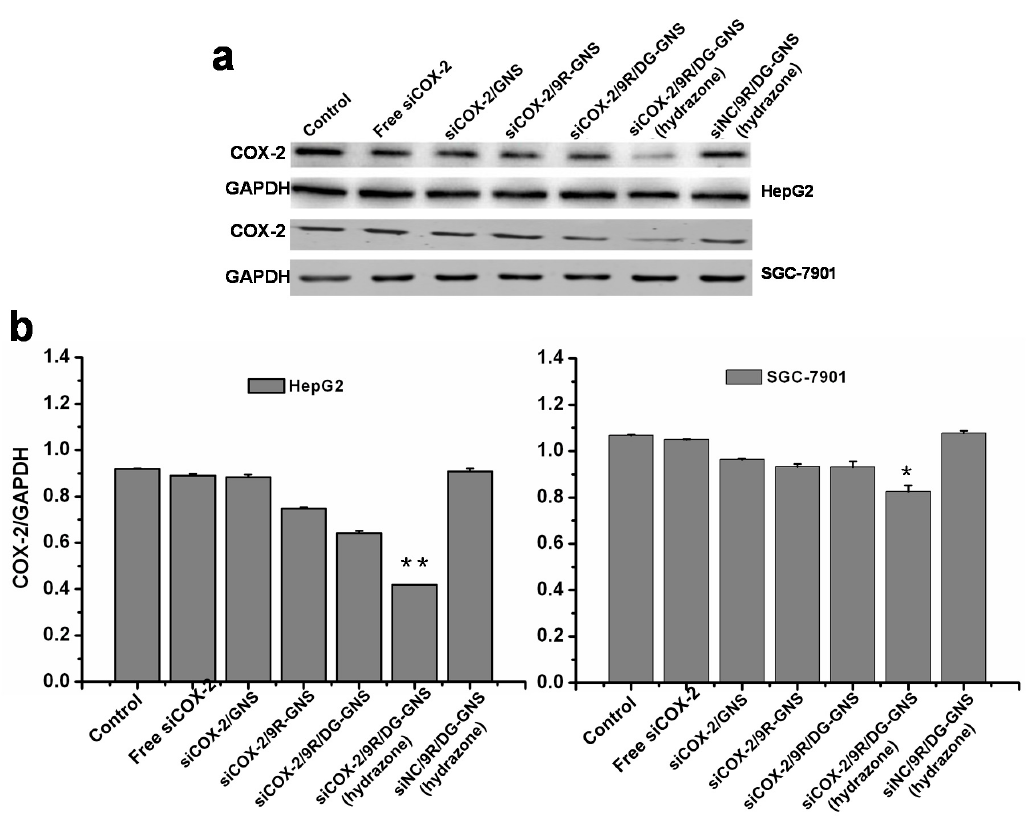
Figure 6. ( a ) COX-2 expressions in HepG2 and SGC7901 cells were observed with Western blot after incubation with free siCOX-2 (lane 2), siCOX-2/GNS (lane 3), siCOX-2/9R-GNS (lane 4), siCOX-2/9R/DG-GNS (lane 5), siCOX-2/9R/DG-GNS (hydrazone) (lane 6), and siNC/9R/DG-GNS (hydrazone) (lane 7) (50 nM). Lane 1 is the COX-2 expression in cells without treatment, and is marked as control. ( b ) Protein bands are quantified with the ratio of grey level of COX-2 to GAPDH. * p < 0.05, ** p < 0.01 vs. other groups. GAPDH, glyceraldehyde-3-phosphate dehydrogenase.